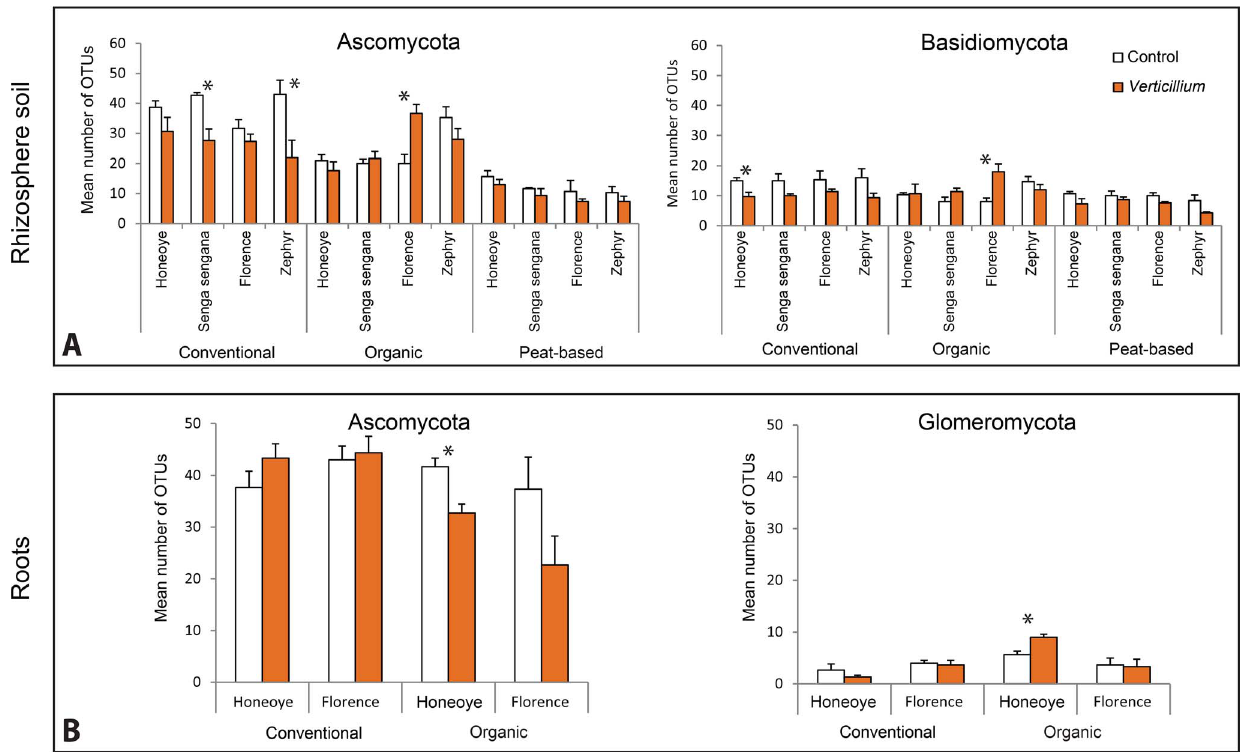
Figure 3. Distribution of fungal operational taxonomic units (OTUs) between different fungal phyla in the rhizosphere (A) and roots (B) of different strawberry cultivars grown in conventionally or organically managed soils or a peat-based growth substrate with and without Verticilliumdahliae . Only OTUs with $ 95% identity are included. Asterisks indicate statistical significance between control and Verticillium dahliae treatments within each soil ( *=p # 0.05, ANOVA). Vertical bars represent mean values and error bars show 6 1 SE